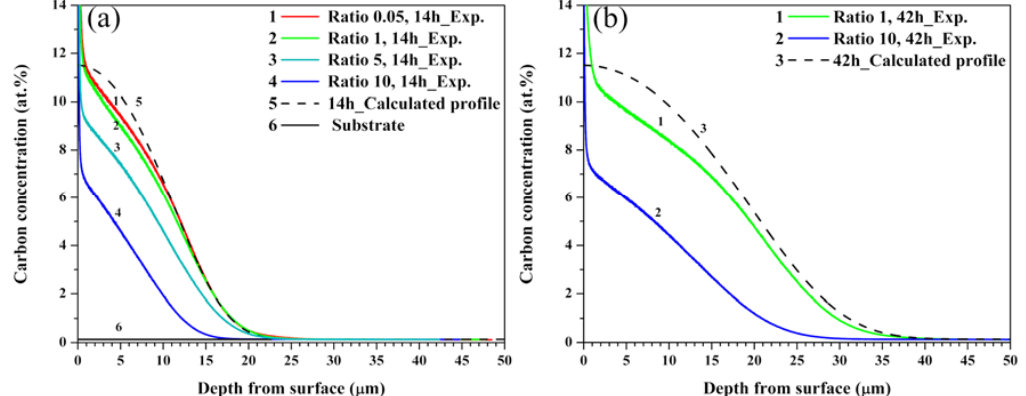
Figure 2. Glow discharge optical emission spectroscopy (GDOES) carbon concentration depth profile of the ASS carburized for ( a ) 14 h and ( b ) 42 h.